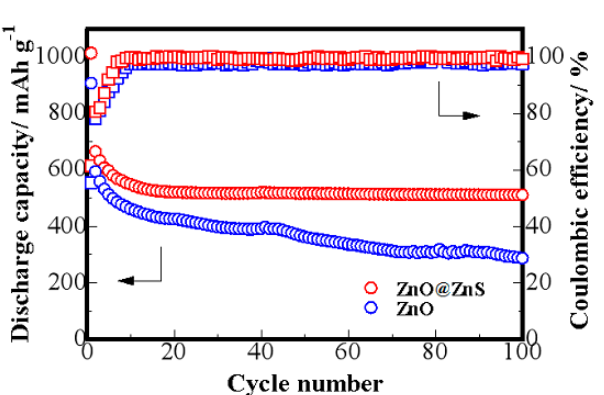
Figure 3. Cyclic performance of the ZnO and ZnO@ZnS electrodes at a current density of 200 mA g − 1 . The rate capabilities of the pure ZnO and ZnO@ZnS nanorods are characterized at different current densities and the results are shown in Figure 4. The ZnO and ZnO@ZnS electrodes exhibit specific discharge capacities of 463.2 (553.3), 330.2 (490.4), 225.5 (385.6) and 157.2 (291.7) mAh g −